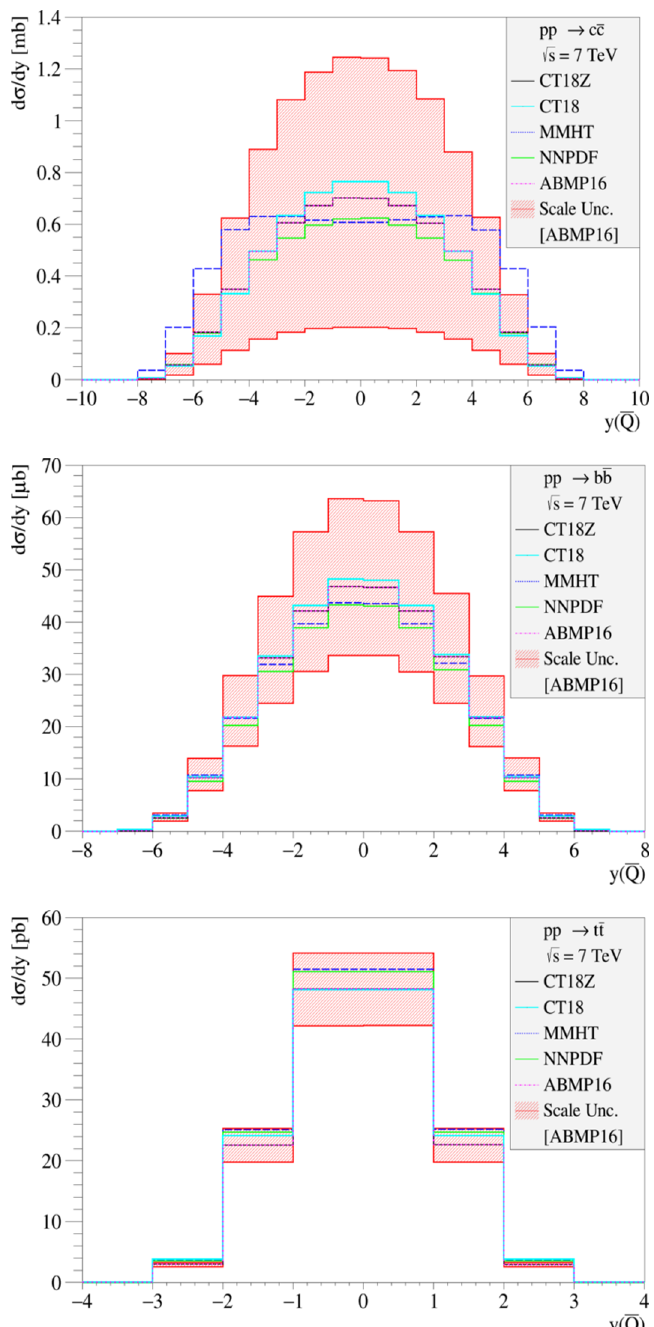
√ s = 7 TeV) for charm (upper